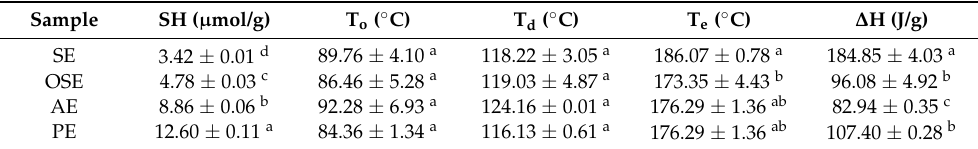
Table 3. Free sulfhydryl group contents and thermal properties of field muskmelon seeds protein extracted by different oil extraction methods.